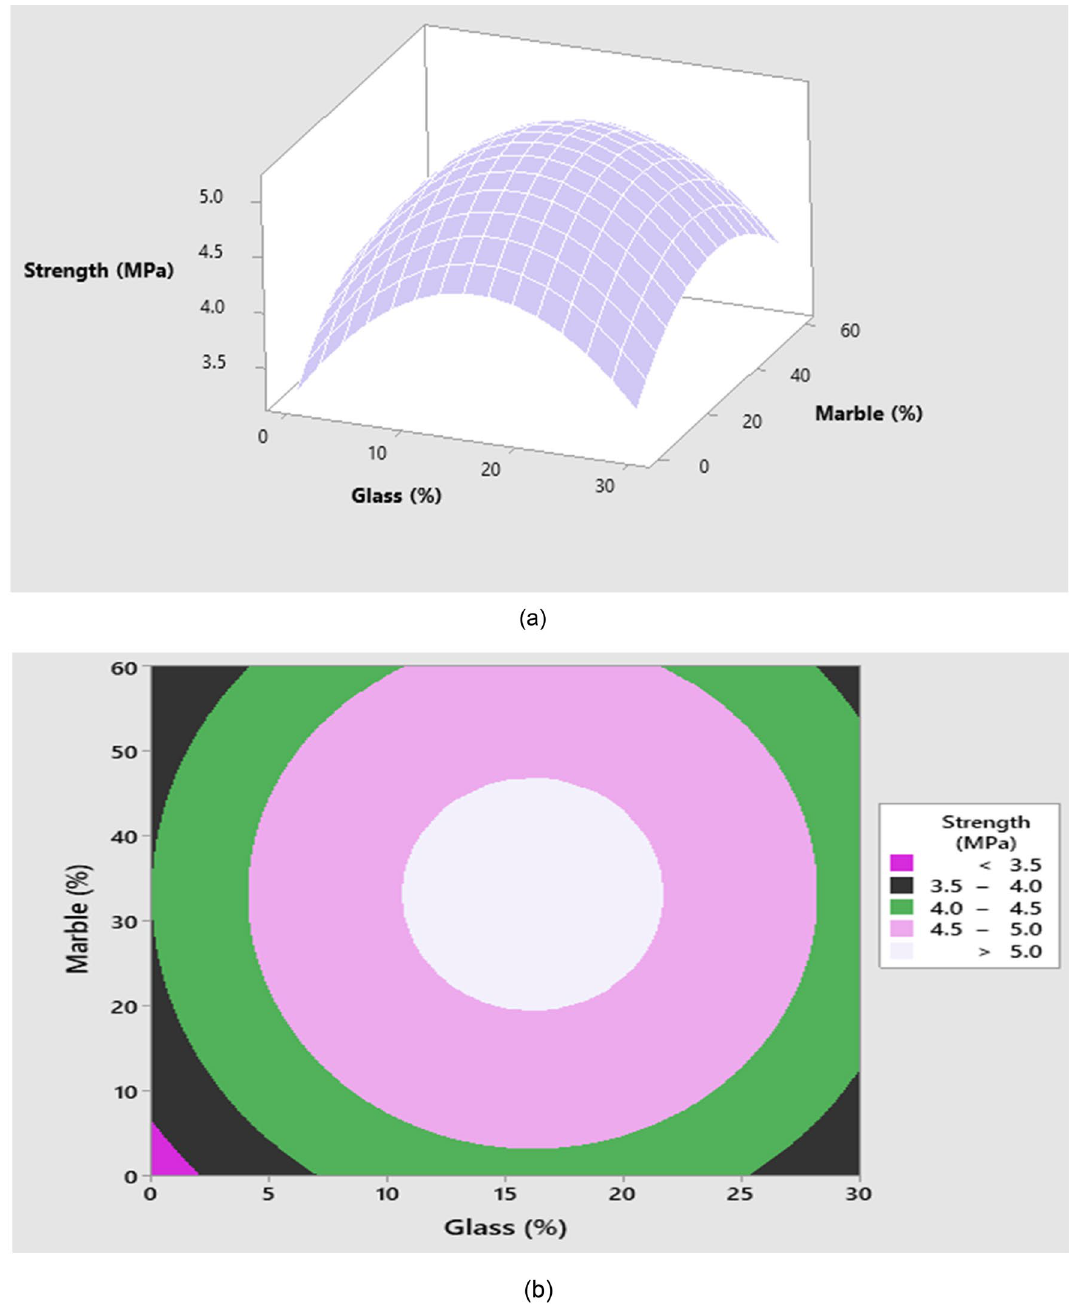
Figure 11. ( a ) 3D response surface and ( b ) Contour plot of split tensile